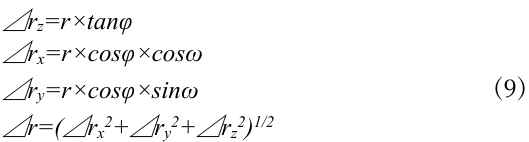
Figure10. Position relations examination conception diagram